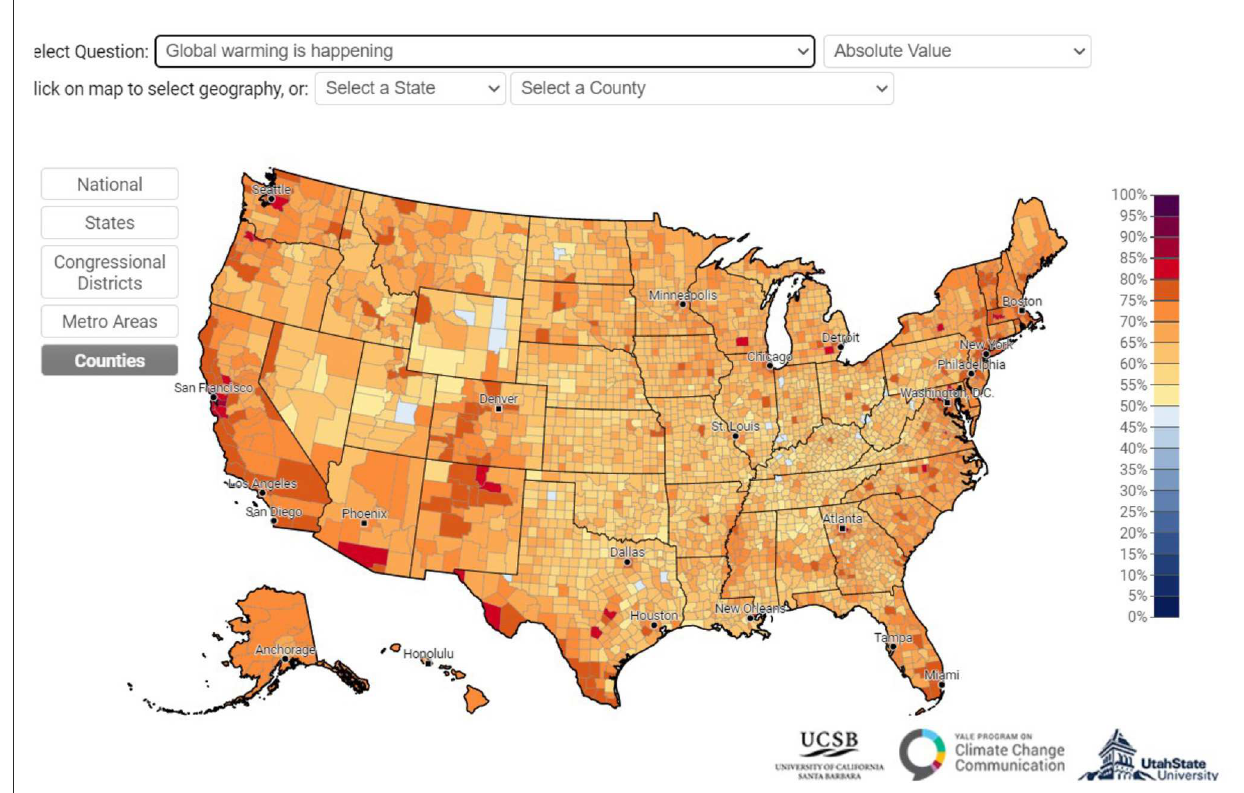
FIGURE4 Yale climate opinion maps. Available online at: https://climatecommunication.yale.edu/visualizations-data/ycom-us/ (accessed December 14, 2022).